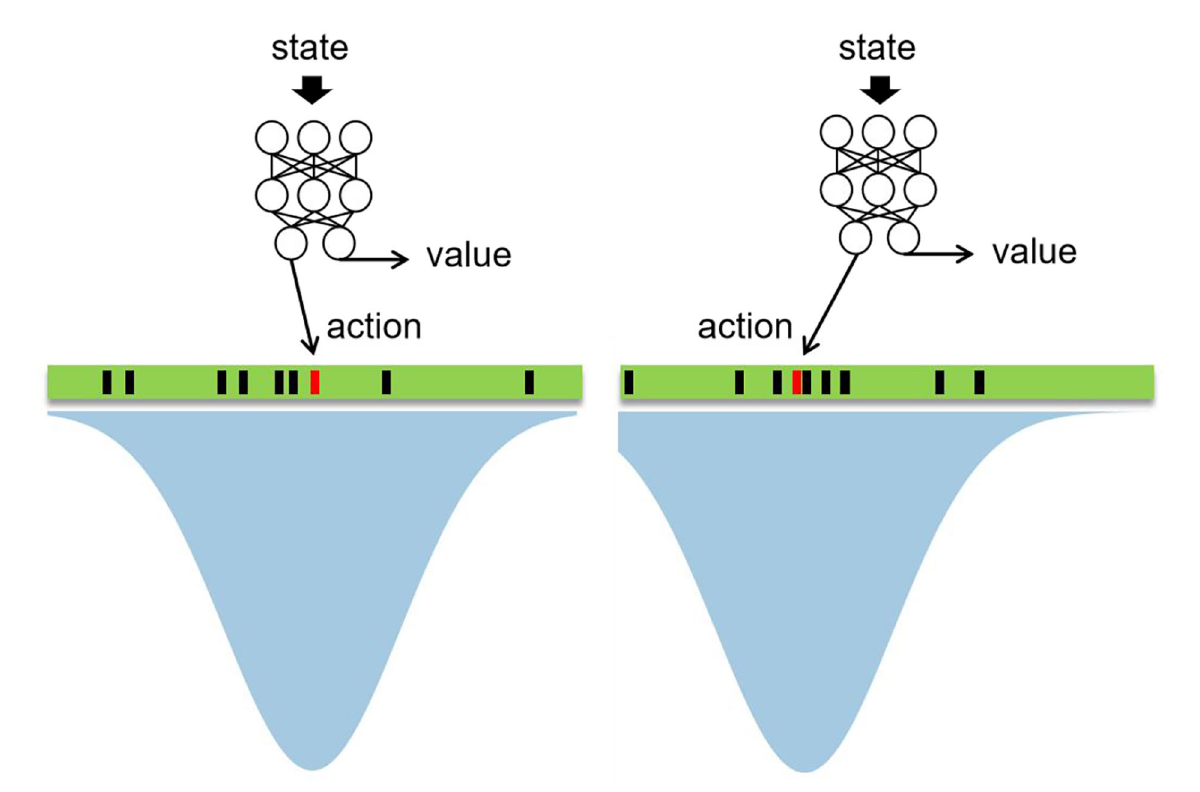
FIGURE1 Generation and selection of action in continuous